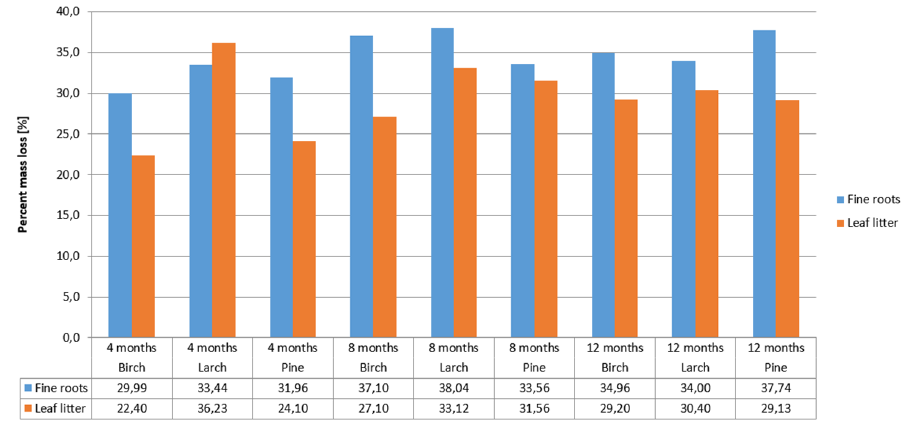
Figure 2. Decomposition rate of leaf litter and fine roots of particular tree species.